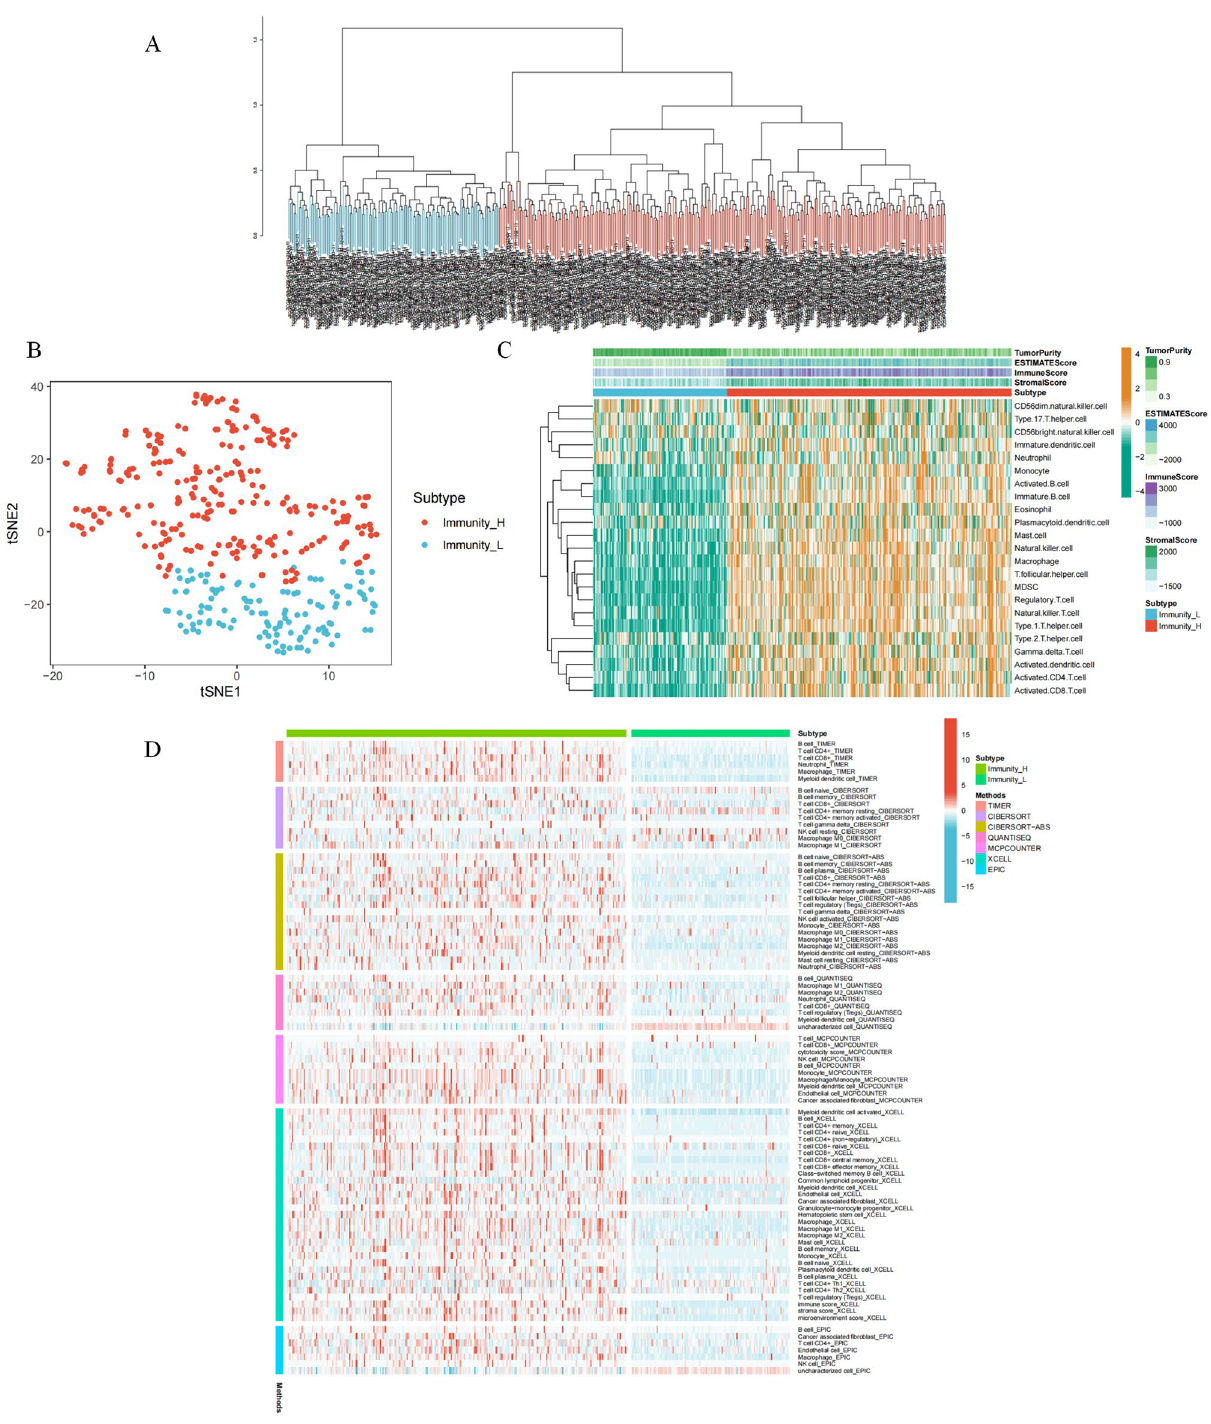
Figure 1. Subtype analysis of patients with TCGA gastric cancer. ( A ) Clustering analysis based on immune cell content. This analysis identified two different patient immunotypes. ( B ) Reduced dimensional analysis of T-SNE based on immune cell content. This figure further validates the immunophenotyping of two different patients. ( C ) Immune cell content calculated by the ssGSEA and ESTIMATE algorithms. ( D ) six algorithms based on TIMER, CIBERSORT, CIBERSORT-ABS, QUANTISEQ, MCPCOUNTER, XCELL, and EPIC for immune cell content assessment. The results show two types of immune patients typed without the bias of the